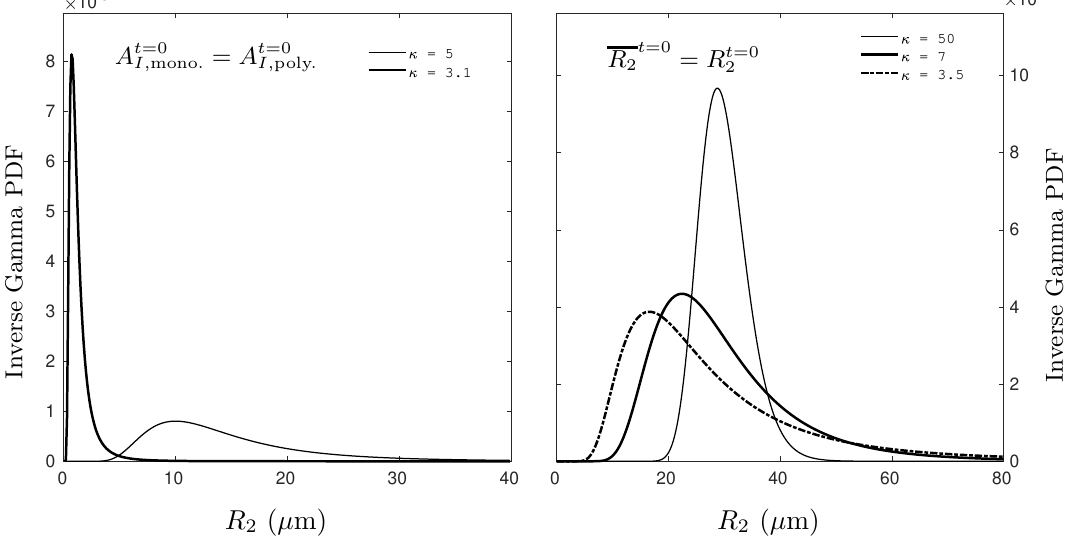
Figure 9: Initial droplet distributions provided by the Inverse Gamma density function with various κ parameters. On the left, a common initial interfacial area A t =0 = A t =0 is considered between the monosdisperse and polydisperse computations I, mono. I, poly. through an appropriate determination of the initial mean radius R 2 t =0 of the polydisperse computation. The single radius R t =0 = 30 µ m of the monosdisperse computation is considered as an input data. The initial mean radius R 2 t =0 of the polydisperse computation is determined with the help of Eq. (4.27) (see Appendix C). The initial mean radius R 2 t =0 is used to find the β t =0 coefficient (Eq. (4.28) Section 4.2.1). On the right, the initial mean radius R 2 t =0 is directly used as an input data. The initial monodisperse and polydisperse mean radii are considered equal: R 2 t =0 = R t =0 = 30 µ m.